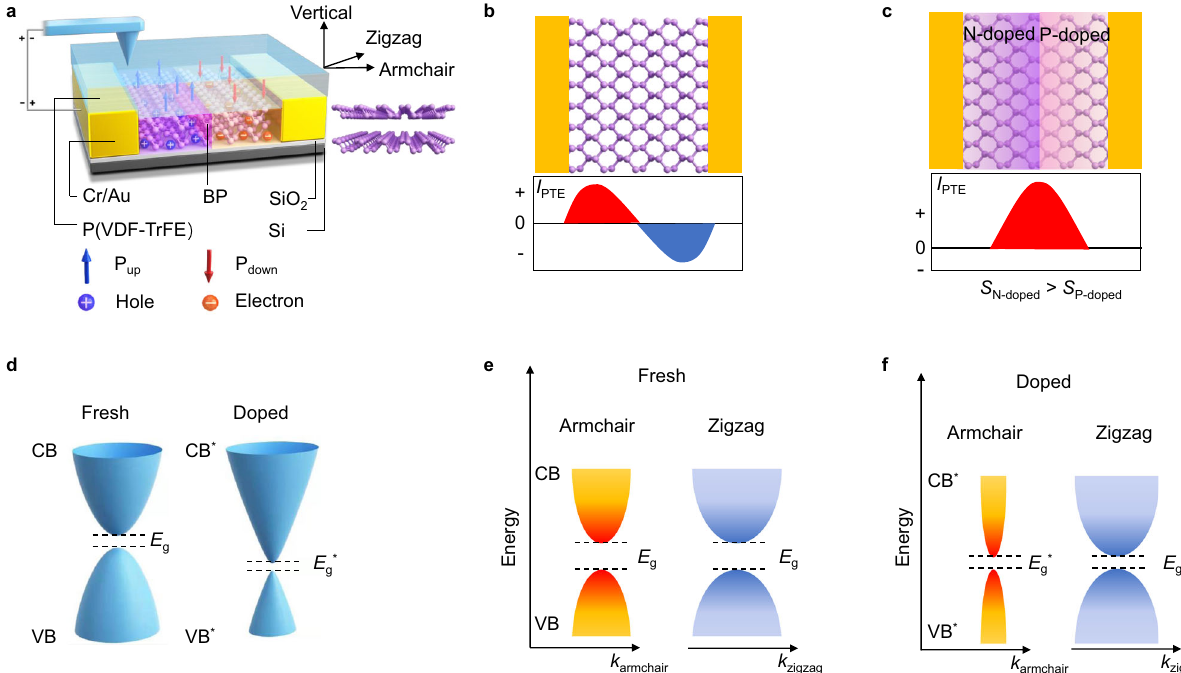
Fig. 1 Device structure designed based on photoelectric mechanism. a Structure schematic of BP in-plane PN homojunction de fi ned by ferroelectric domains. P up and P down represent the ferroelectric copolymers are totally polarized upward and downward by piezoresponse force microscopy (PFM) conductivec probe. AC and ZZ axes correspond to the armchair and zigzag direction of BP crystal structure. b Photothermoelectric (PTE) current ( I PTE ) in BP device at zero bias. Red (blue) area represents positive (negative) contribution to the PTE current. c PTE current in BP in-plane PN junction device at zero bias. S N-doped and S P-doped correspond to the Seebeck coef fi cient of n-doped BP and p-doped BP. d Band structure of BP in the fresh state and the electrical doped state. Under large electric fi eld, bandgap decreases after electrical doping, and the band dispersion becomes nearly linear in the AC direction while remains parabolic in ZZ direction. e Anisotropic band structure of BP in the fresh state along the AC direction ( k armchair ) and ZZ direction ( k zigzag ). CB, VB, and E g correspond to conduction band, valence band and bandgap of BP in fresh state, respectively. f Anisotropic band structure of BP in the doped state along the armchair direction and zigzag direction. CB * , VB * , and E g * correspond to conduction band, valence band, and bandgap of doped BP,